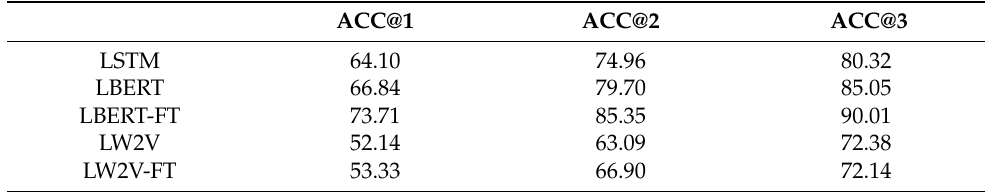
Table 2. Accuracy of prediction